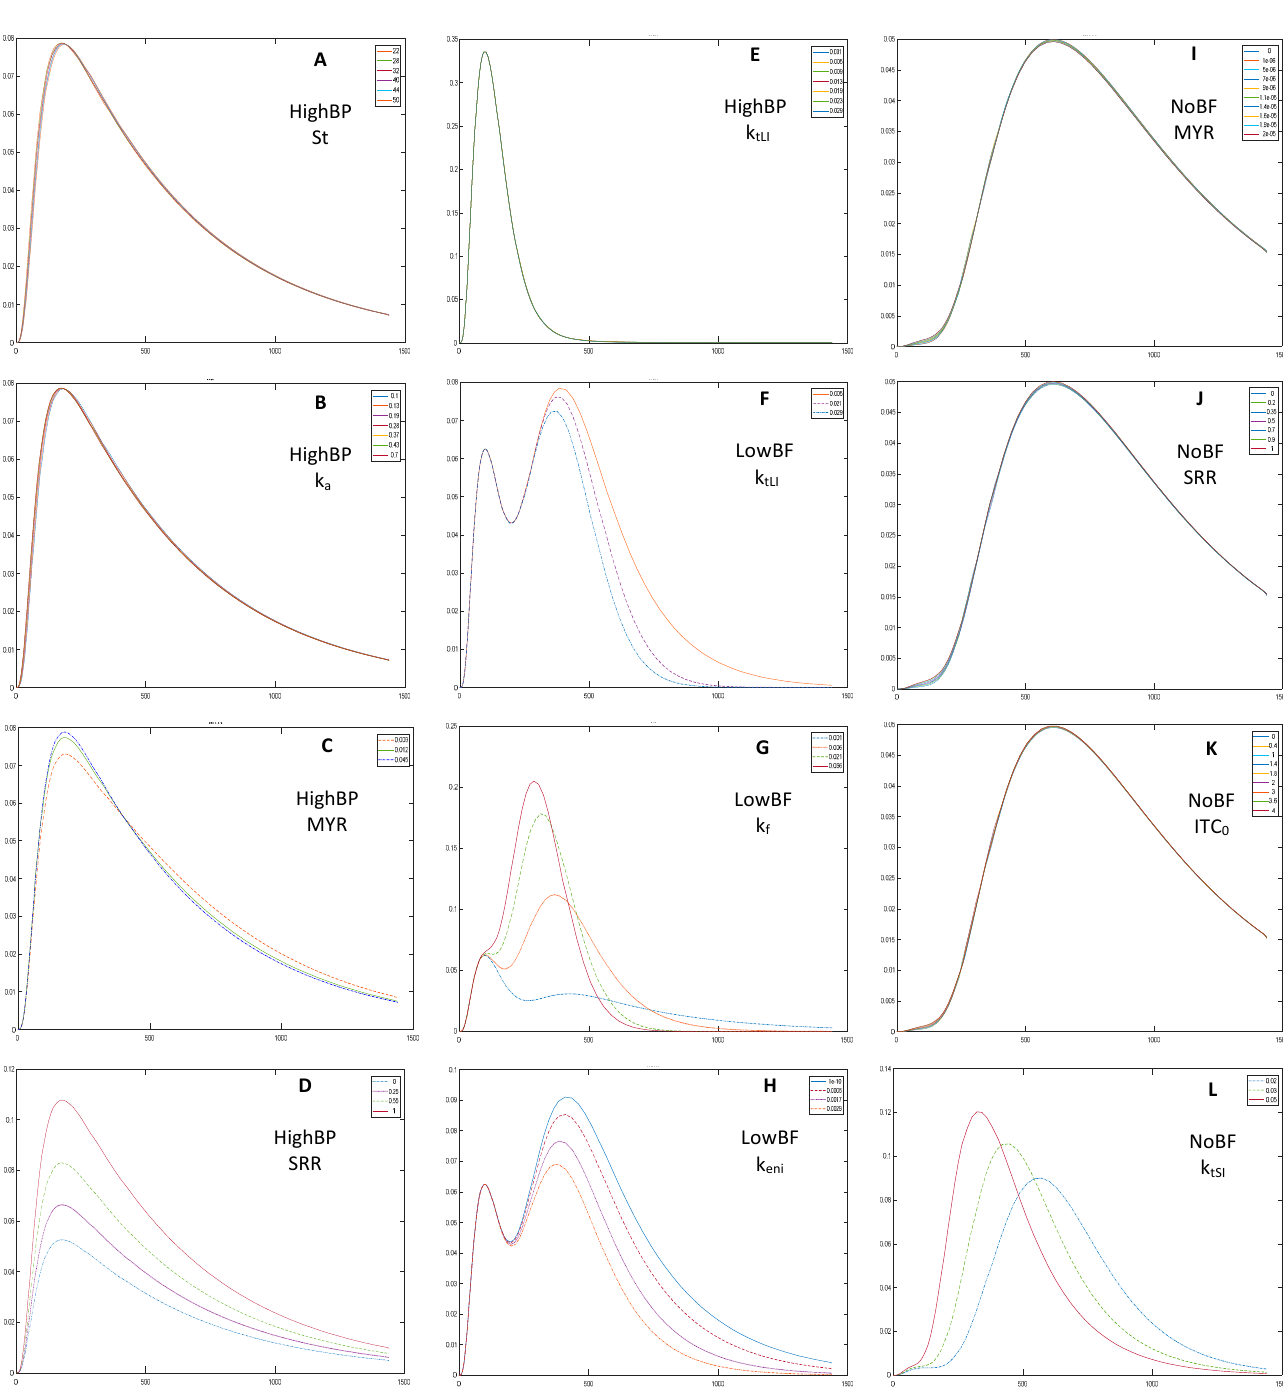
Figure 3. HighBP sensitivity analysis for ( A ) gastric emptying time, St; ( B ) the rate constant of absorption, k a ; ( C ) myrosinase content, MYR; ( D ) the ratio of GR converted to SR in the mouth, SRR; ( E ) large intestine transit rate constant, k tLI . LowBF sensitivity analysis for ( F ) large intestine transit rate constant, k tLI ; ( G ) ITC formation rate constant in the gut, k f ; and ( H ) erucin and nitrile formation rate constant in the gut, k eni . NoBF sensitivity analysis for ( I ) myrosinase content, MYR; ( J ) the ratio of GR converted to SR in the mouth, SRR; ( K ) and initial ITC concentration (ITC 0 ) and ( L ) small intestine transit rate constant, k tSI . The sensitivity analysis shows how the simulation output changes when all parameters are kept constant while one